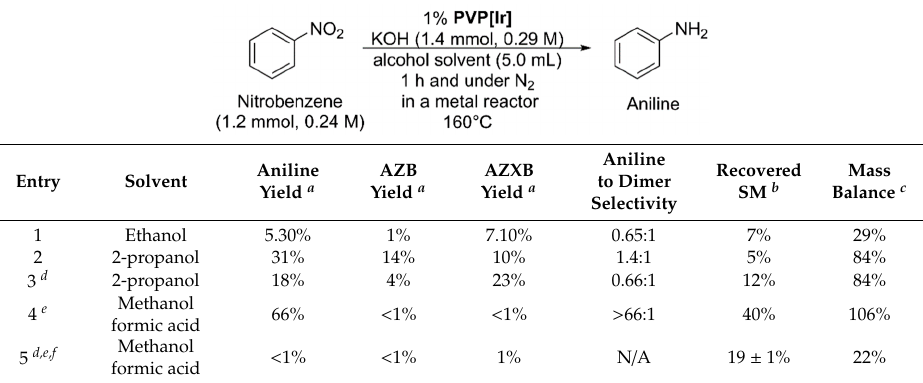
Table 1. PVP[Ir] in the catalytic transfer hydrogenation of nitrobenzene to aniline.